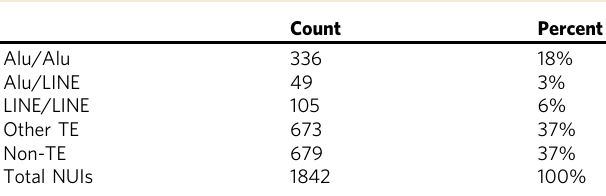
Table 3 Distribution of transposable elements fl anking all non-reference unique insertions